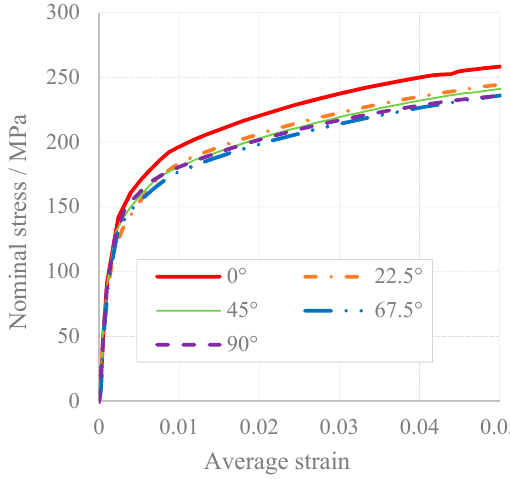
Figure 7. Maximum principal strain distribution.